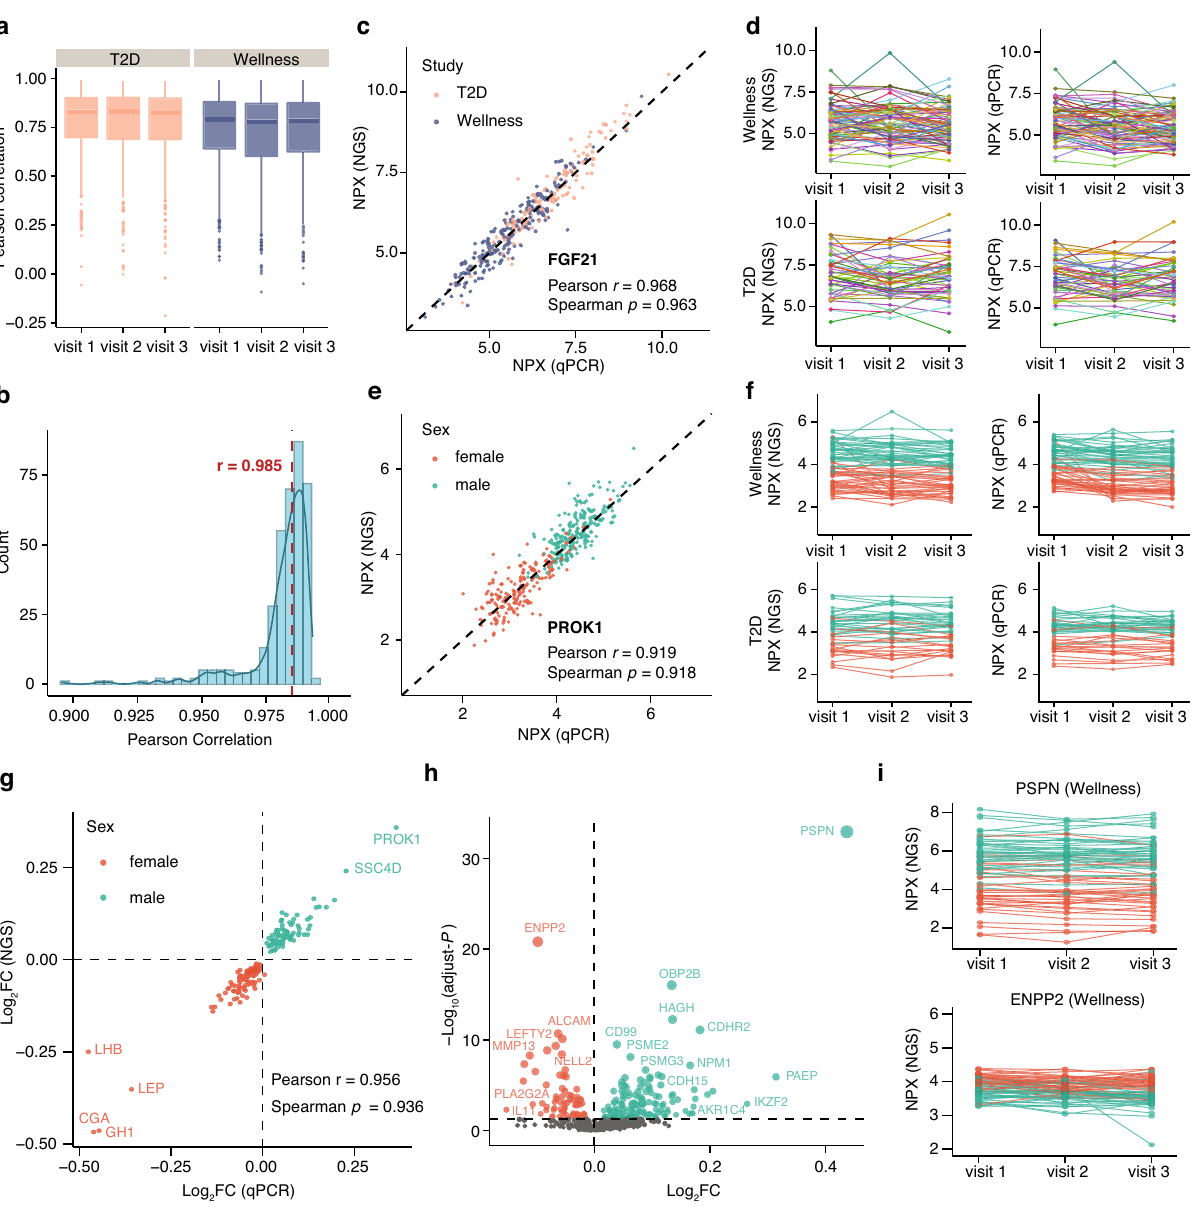
Fig. 2 Correlation between PEA with NGS and qPCR measurements. a Protein-wise correlation between NGS and qPCR for all proteins analyzed in each visit of the healthy and disease cohorts. Box plots show medians and the 25th and 75th percentiles, whiskers show the largest and smallest values ( n = 761 proteins). b A combined boxplot and density plot showing the distribution of the sample-wise correlation values between NGS and qPCR measurements. The red dotted line shows the median Pearson correlation for all samples. c A scatter plot showing the pairwise correlation between the expression levels of NGS and qPCR platforms for the FGF21 protein. d The longitudinal protein pro fi le for FGF21 in wellness and T2D. The color code indicates individuals. e A scatter plot showing the pairwise correlation between the expression levels of NGS and qPCR platforms for PROK1. f The longitudinal protein pro fi le for PROK1 in wellness and T2D. The color code indicates individuals. g A scatter plot showing the pairwise correlation between the fold change in male and female samples measured by NGS and qPCR platforms for sex-related proteins identi fi ed in the wellness cohort. h A volcano plot showing the newly identi fi ed differentially expressed proteins in male and female samples. The X -axis represents log 2 fold-change (FC) and the Y -axis represents log 10 (adjusted P values). Differentially expressed proteins were de fi ned as proteins with adjusted P values < 0.05 (three-way balanced ANOVA for gender with age and visit as covariates). Multiple test corrections have been applied for P -values using Benjamini and Hochberg method. i The protein concentration variation across visits one to three, with each individual connected with a dotted line for PSPN and ENPP2 proteins in the wellness cohort. The color code indicates females and males. Source data are provided as a Source Data fi